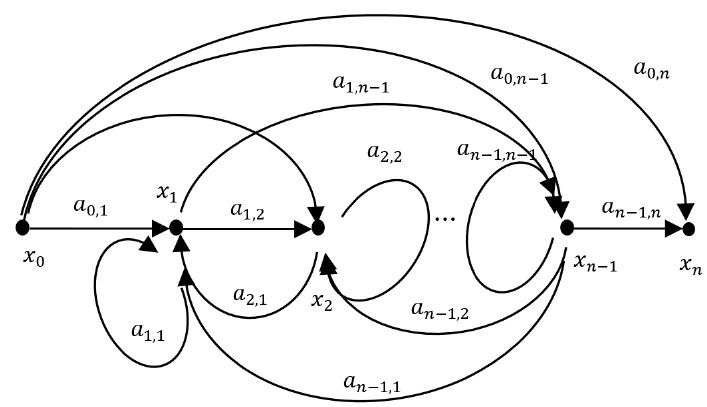
Figure 1. A signal flow graph.